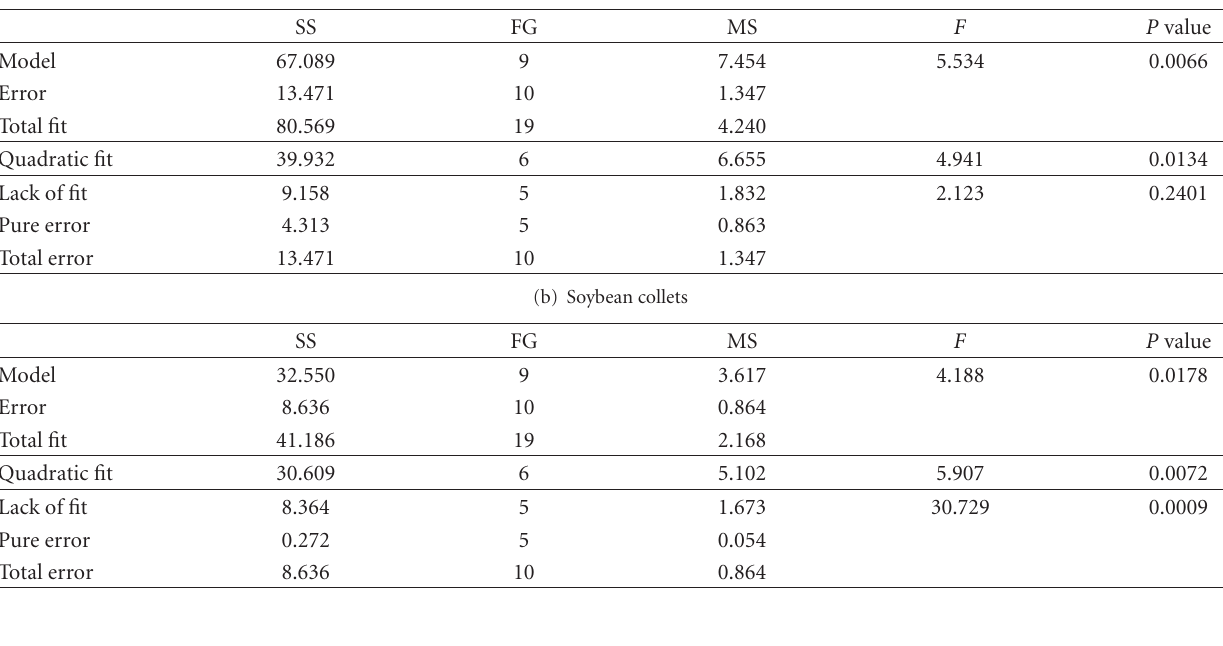
Table 4: Optimum enzymatic incubation conditions to obtain maximum theoretical oil yield.